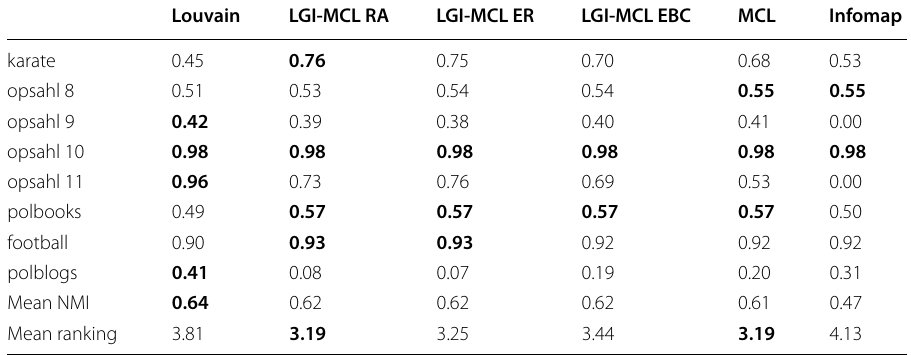
For each real network, 100 perturbed networks have been generated adding at random the 10% of links. The table reports the Normalized Mutual Information (NMI) computed between the ground‑truth communities and the ones detected by every community detection algorithm for the 8 real networks, averaged over the 100 repetitions. NMI match between the two partitions of the nodes. The methods are ranked by mean NMI over the dataset. The best result for each network as well as the best mean results are marked in